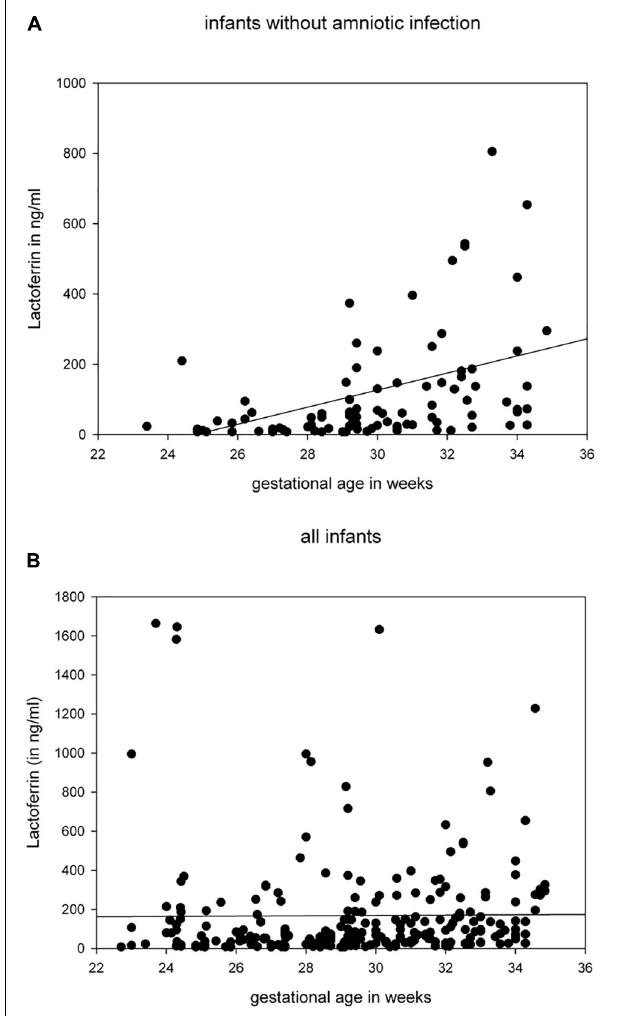
FIGURE 1 | LF in ng/ml in peripheral blood of preterm infants taken at day 1 correlated with gestational age (in weeks) [ (A) infants born without clinical signs of amnionic infection r = 0.491, p < 0.001, n = 96 (1 outlier not shown), (B) all infants].